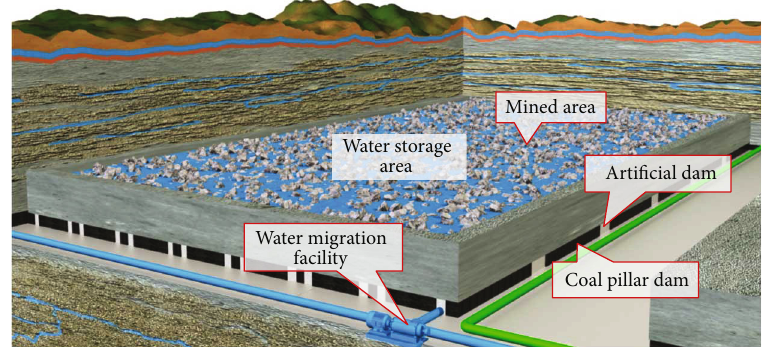
Figure 1: Technical idea sketch of the underground reservoir of a coal